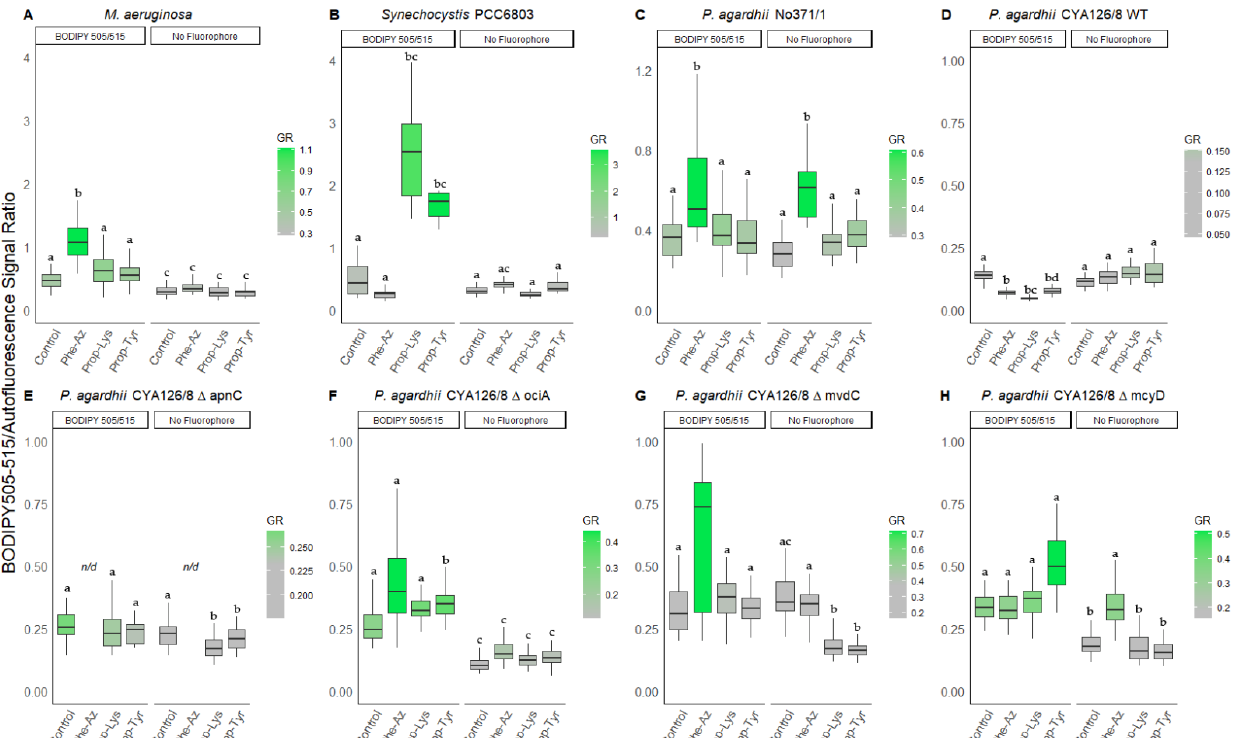
Figure 5. Ratio of green fluorescence intensity (BODIPY) and red intensity (AF) for individual cells or filaments from ( A ) M. aeruginosa , ( B ) Synechocystis PCC6803, and ( C ) P. agardhii strain No371/1, ( D ) CYA126/8 WT, and ( E – H ) CYA126/8 gene knock out mutants: ( E ) Δ apnC (inactivated AP synthesis), ( F ) Δ ociA (inactivated cyanopeptolin synthesis), ( G ) Δ mvdC (inactivated microviridin synthesis), ( H ) Δ mcyD (inactivated MC synthesis) using non-natural amino acids (Phe-Az, Prop- Lys, Prop-Tyr). Controls were grown without amino acid addition. No Fluorophore indicates filaments or cells grown with amino acid addition but no BODIPY labeling. The gradient in coloring was defined using the average intensity from the control cultures without supplementing amino acids. Superscripts indicate statistically significant different subgroups after overall difference was found ( p < 0.05); n/d: no data.